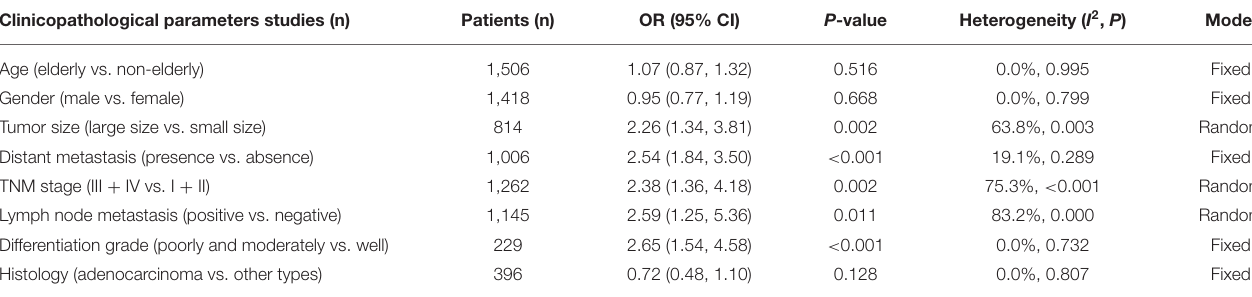
TABLE 2 | Association of MIAT expression with clinicopathological features. Clinicopathological parameters studies